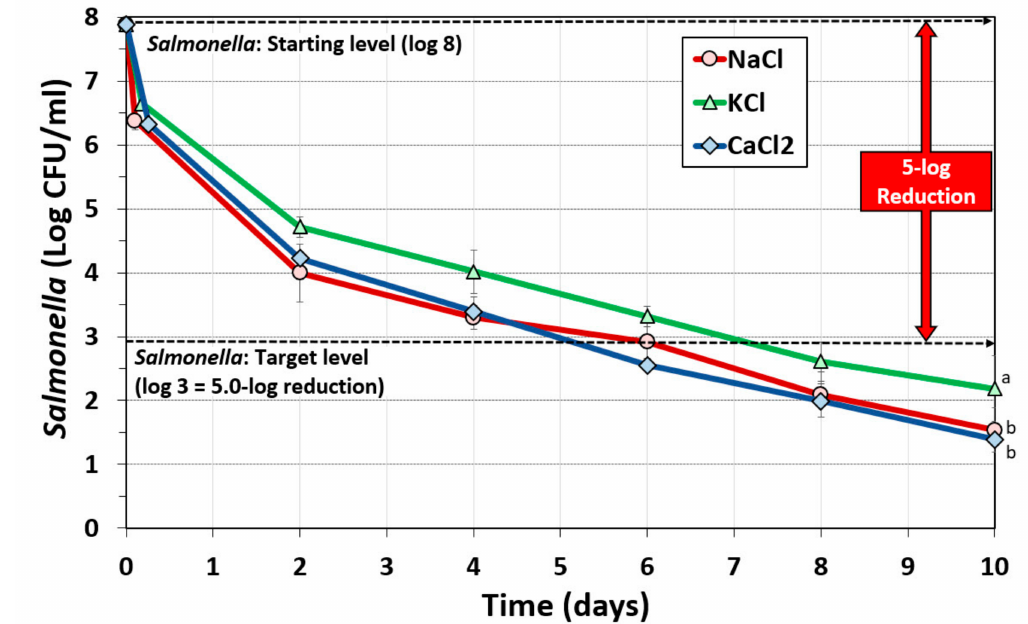
Figure 2. Biltong processing using alternative salts for reduction of Salmonella. Comparison of NaCl, KCl, and CaCl 2 at a concentration of 2.2% to attempt a 5-log reduction of Salmonella population over a period of ten days at 23.9 ◦ C (75 ◦ F) and 55% relative humidity (RH). Statistical analysis of entire time course of graphs: treatments with the same letter are not significantly di ff erent ( p > 0.05); treatments with di ff erent letters are significantly di ff erent ( p <